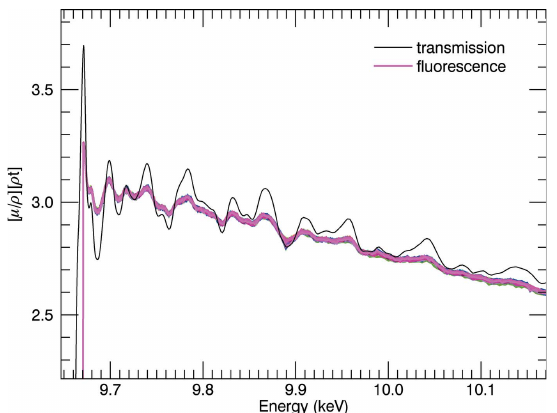
Figure 17 Near-edge region comparing the transmission spectra with data collected in fluorescence mode and processed by SeAFFluX . The form matches very closely but the magnitude of the XAFS in fluorescence is (cid:9) 0.3 that of transmission.